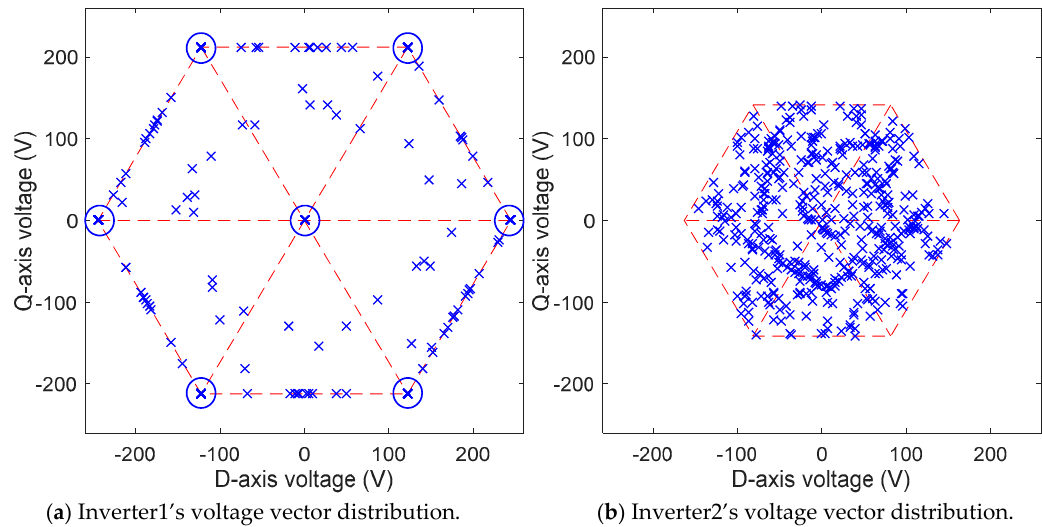
Figure 16. Inverter voltage vector distribution in static DQ plane.